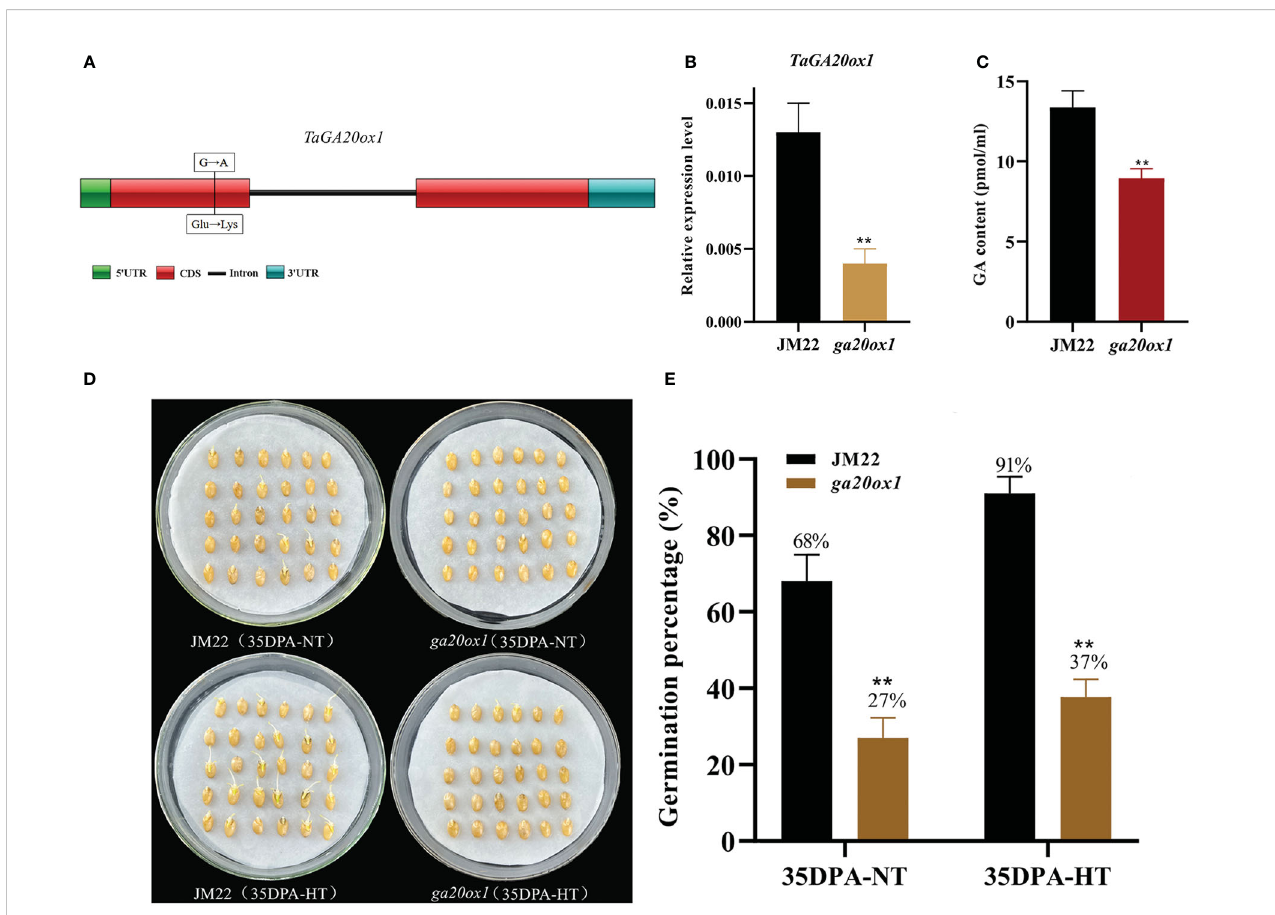
FIGURE 2 Mutation site, GA contents and germination percentages of the EMS mutant ga20ox1. (A) Mutation site of ga20ox1 . (B) Relative expression levels of GA20ox1 in mutant lines and JM22. Signi fi cant differences were determined using Student ’ s t-test: **P < 0.01. (C) GA contents of Jimai 22 (JM22) and ga20ox1 seeds at 96 h after imbibition. (D) The seed images of Jimai 22 (JM22) and the EMS mutant ga20ox1 after 96 h imbibition conducted under normal-temperature (25°C/20°C) and high-temperature (35°C/25°C) environments. (E) Germination percentages of JM22 and the EMS mutant ga20ox1 on the 7th day of germination tests conducted under normal-temperature (25°C/20°C) and high-temperature (35°C/25°C) environments. Data represent the mean ± standard error (SE), n = 10 –